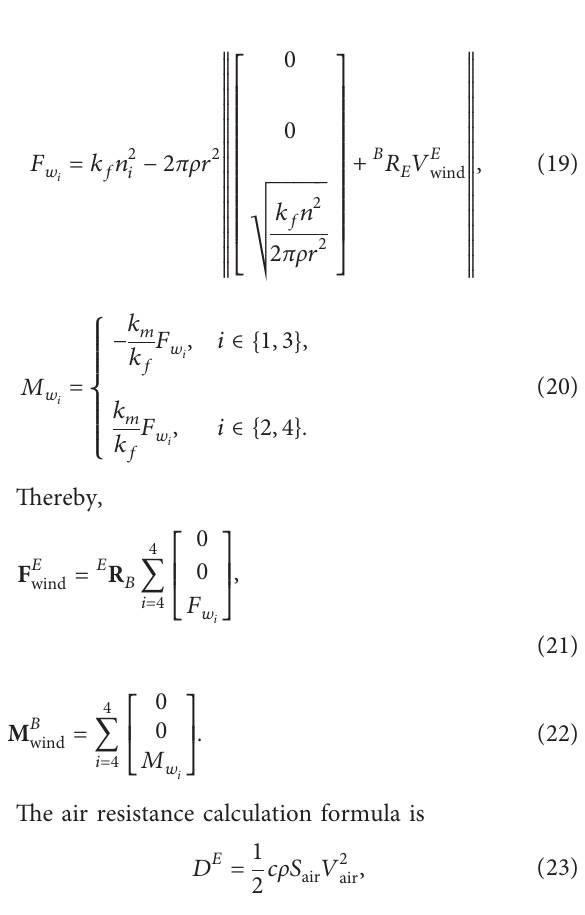
Figure 2: Aerodynamics of rotor under wind